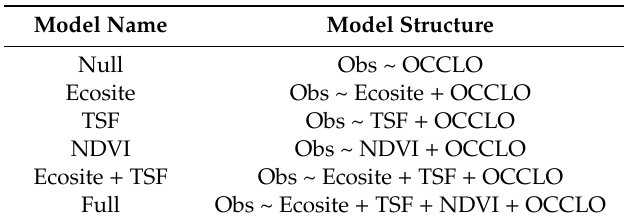
Table A4. Name and structure of candidate models used to create the canopy closure layer for modelling lichen presence and abundance. Obs = canopy closure recorded in the field; OCCLO = canopy closure derived from the inventory datasets; TSF = time since fire (years), NDVI (normalized di ff erence vegetation index).